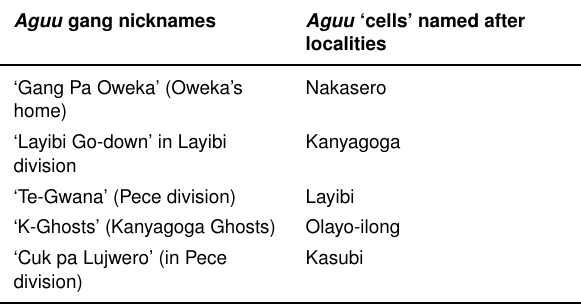
Table 1. Examples of Gang Nicknames in Gulu.